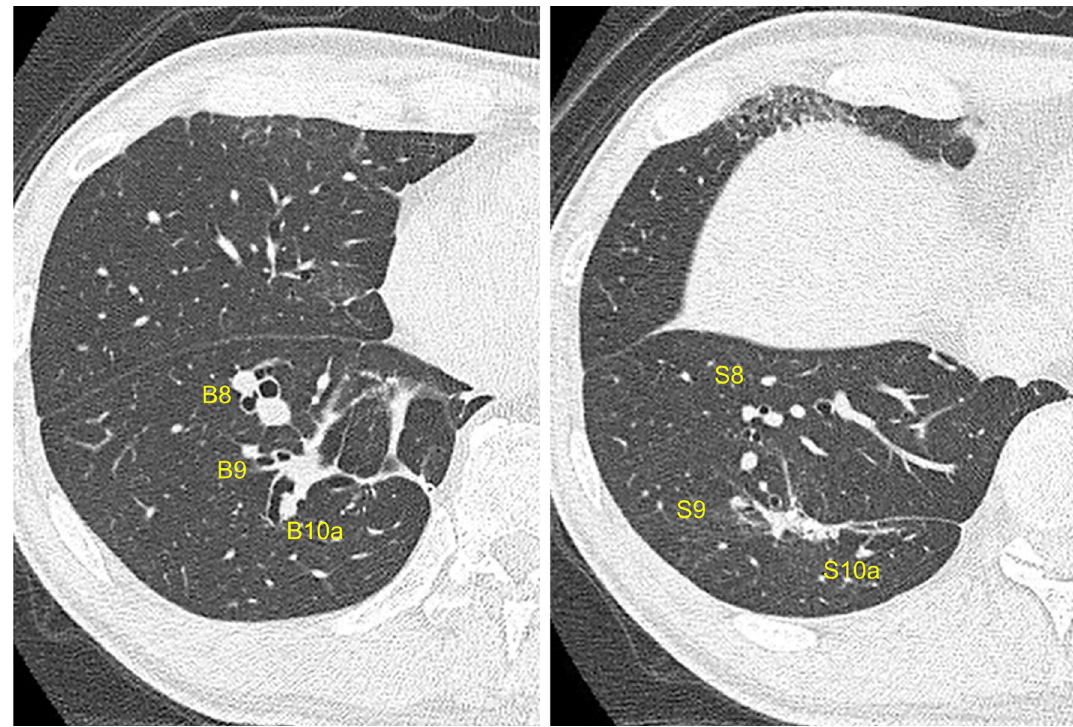
Fig. 4 Postoperative image of computed